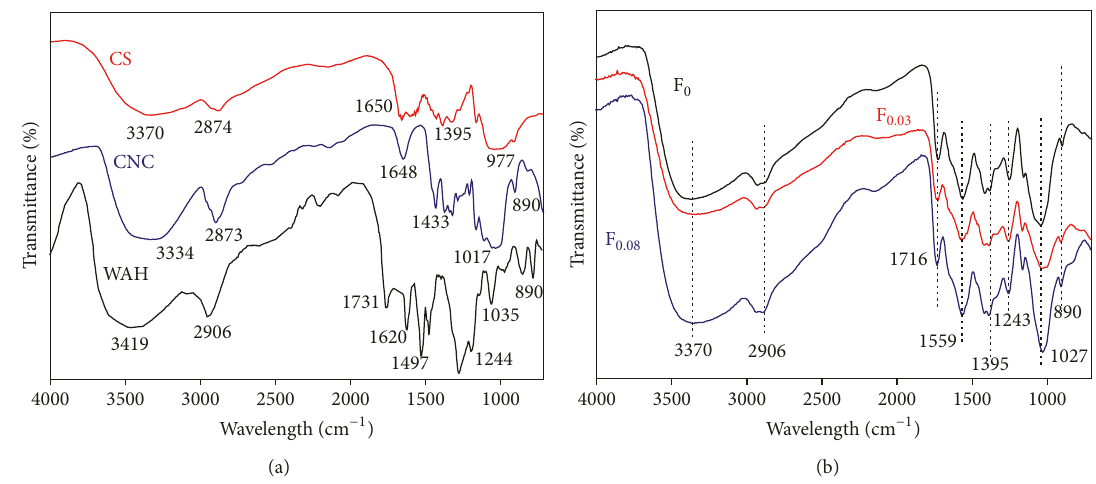
Figure 3: (a) The FT-IR spectra of WH, CS, and CNC. (b) The FT-IR spectra of the composite films (F 0 , F 0.03 , and F 0.08 ).